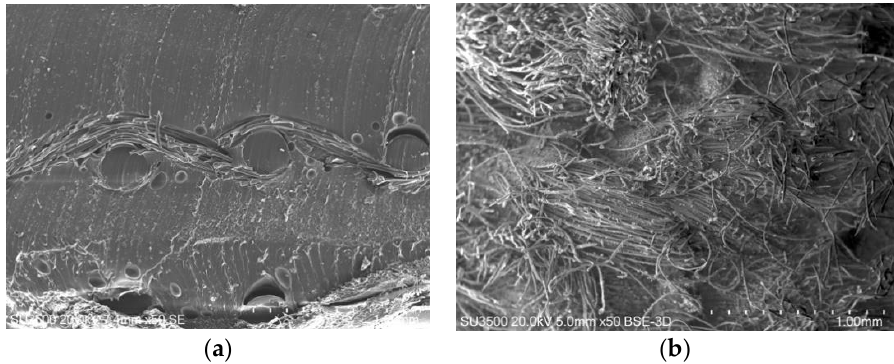
Figure 11. SEM images of: ( a ) cross-section; ( b ) bottom side of material samples for KKA 80-80 test variant.